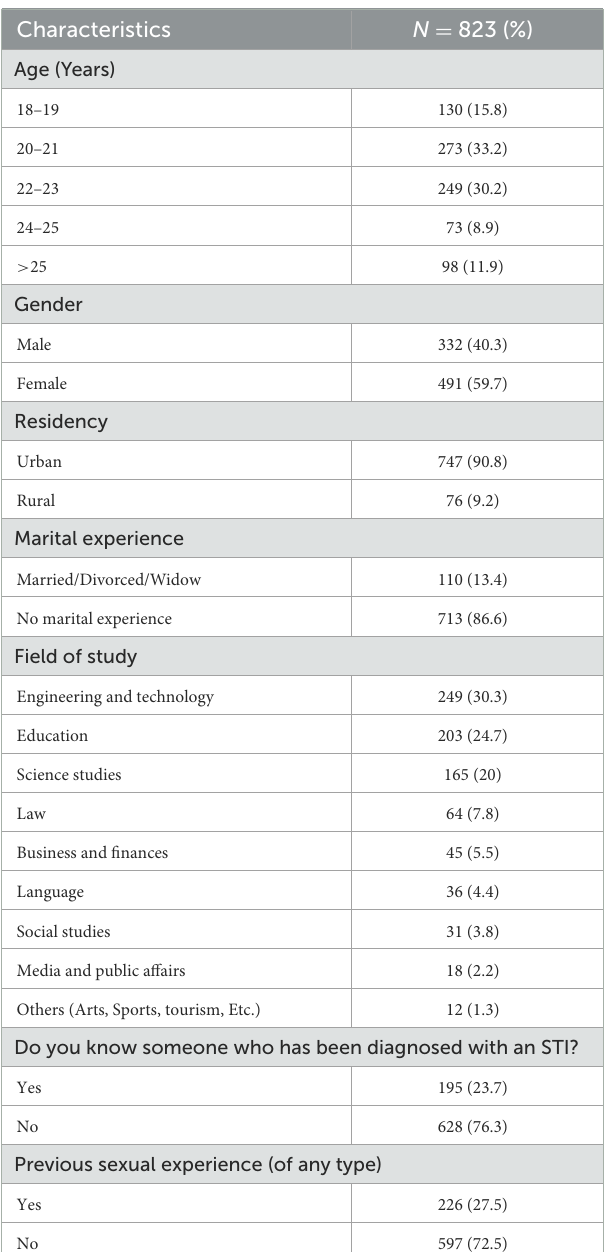
TABLE 1 Sample socio-demographic